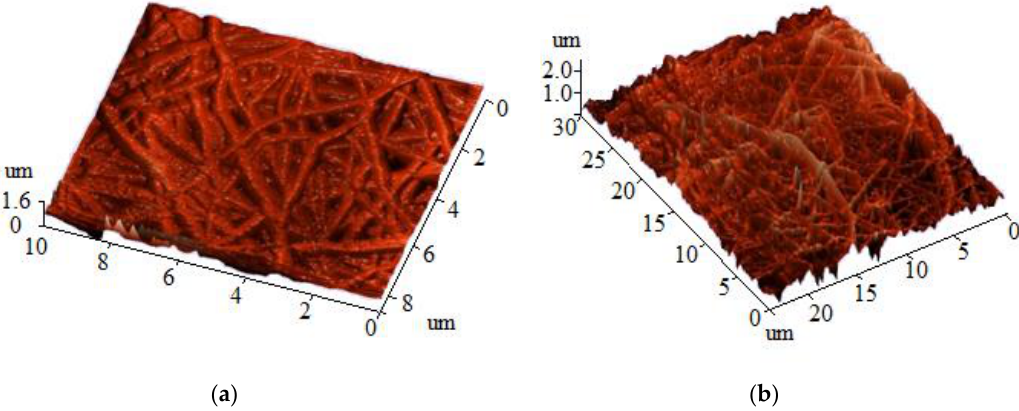
Figure 4. AFM imaging of the surface of the nonwoven material’s ( a ) HA-face and ( b )